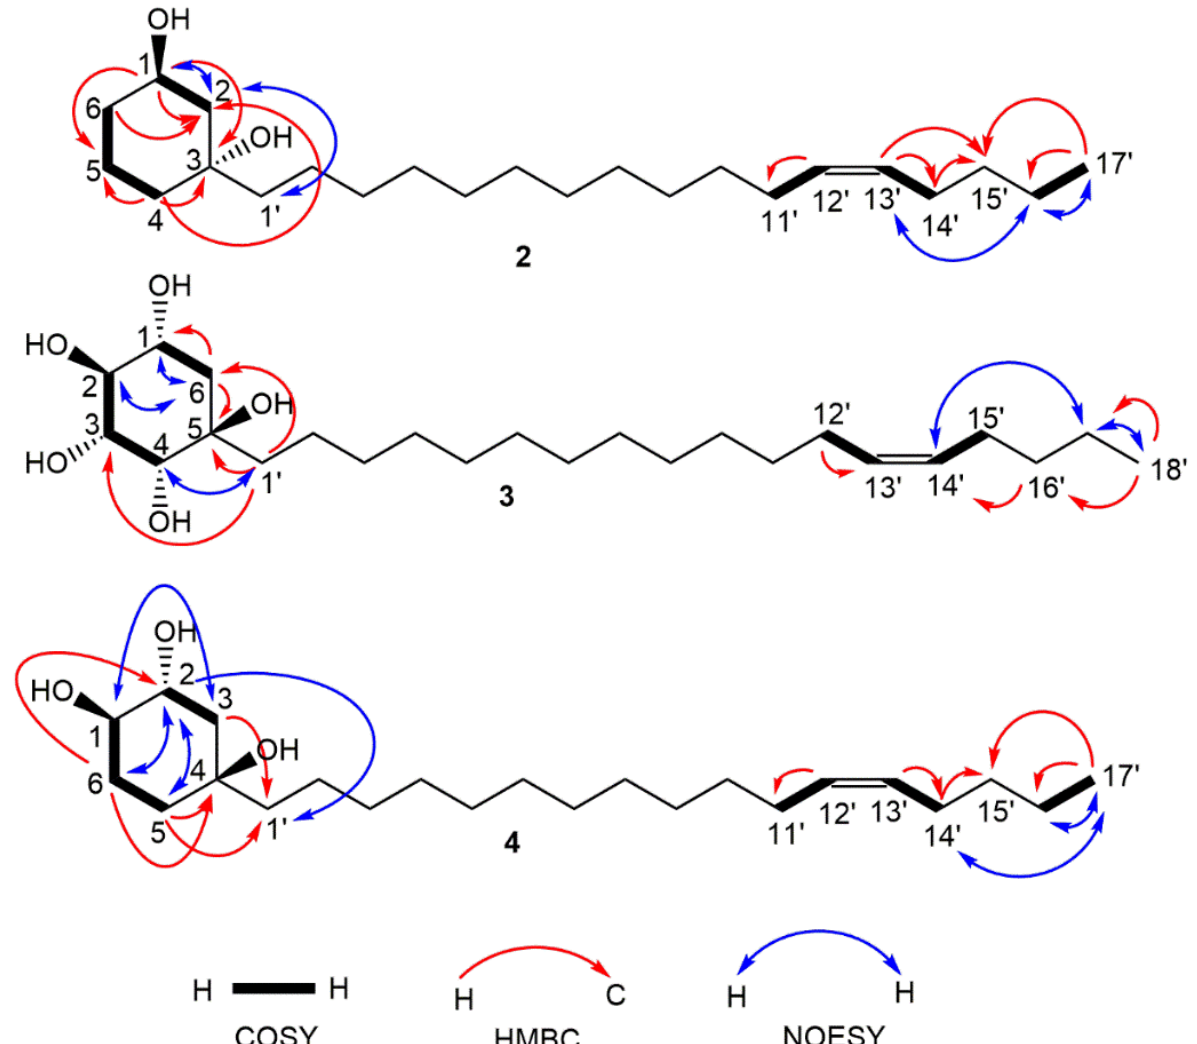
Figure 2. Major correlations, COSY (thick black line), HMBC (red arrow) and NOESY (blue arrow), observed for compounds 2 , 3 and 4 .